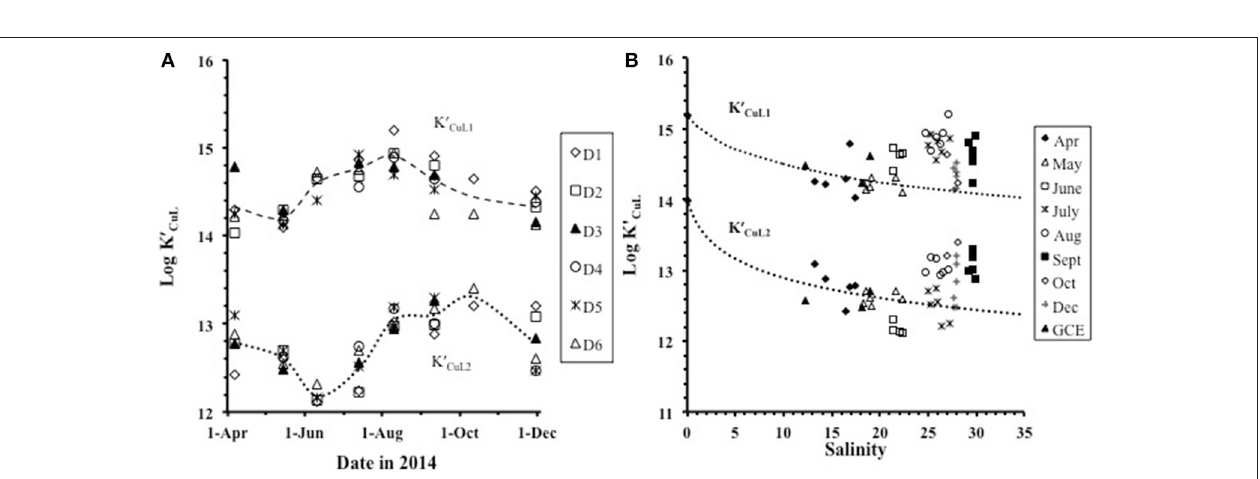
FIGURE 3 | The trend in log K ′ CuL1 and log K ′ CuL2 (A) over the seasonal cycle from April to December and (B) with salinity. The dotted lines in (B) show the modeled trend with salinity for log K ′ CuL1 and log K ′ CuL2 . Plot (B) includes the freshwater end-member station 10 sampled in